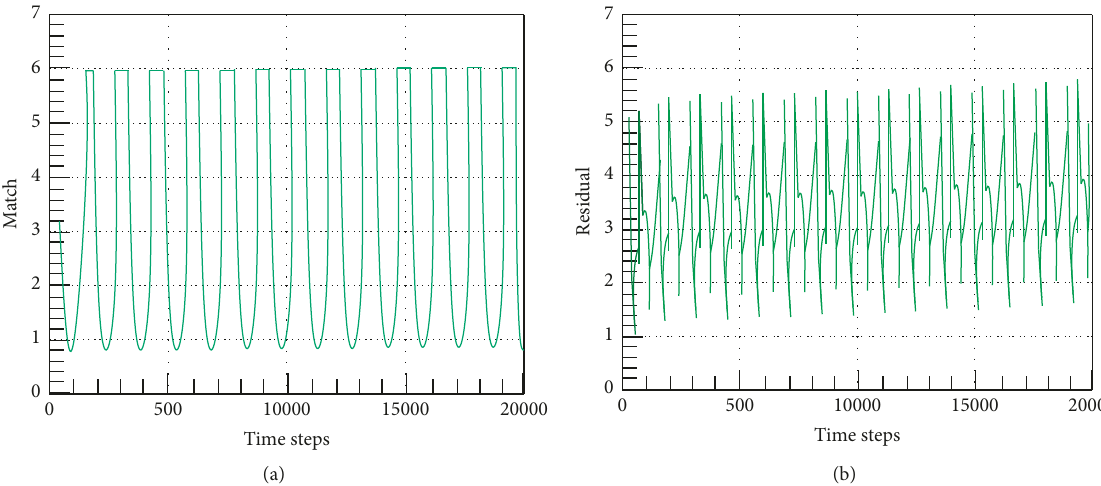
Figure 4: One-dimensional “carbuncle” problem calculated in HLLEM format ( M 0 � 6.0, ε � 0.3. For clarity, only the results before 20000 time steps are shown in the figure). (a) Mach number. (b) Residual value convergence